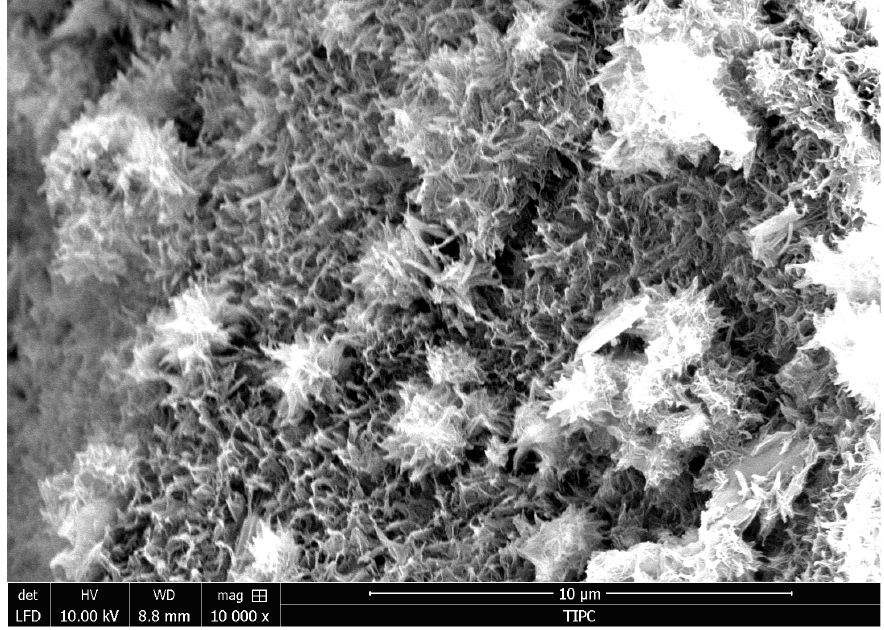
Figure 4. Floc structure in block.